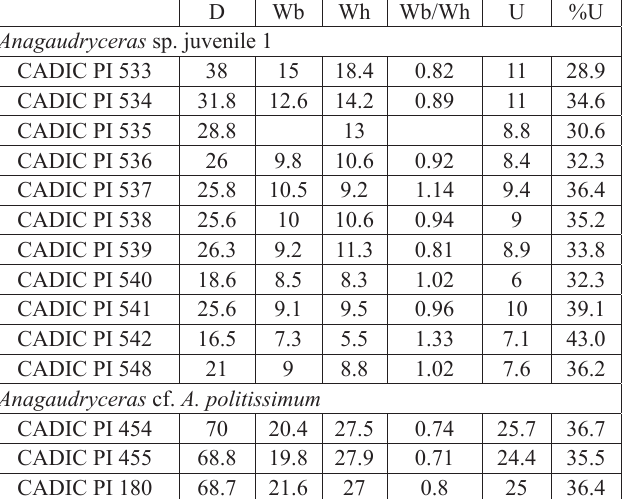
Table 3. Dimensions (in mm) of Anagaudryceras sp. juvenile 1 and Anagaudryceras cf. politissimum . Abbreviations: D, diameter; U, um- bilical diameter; %U, umbilical dia meter as % of D; Wb, whorl breadth at a given D; Wh, whorl height at a given